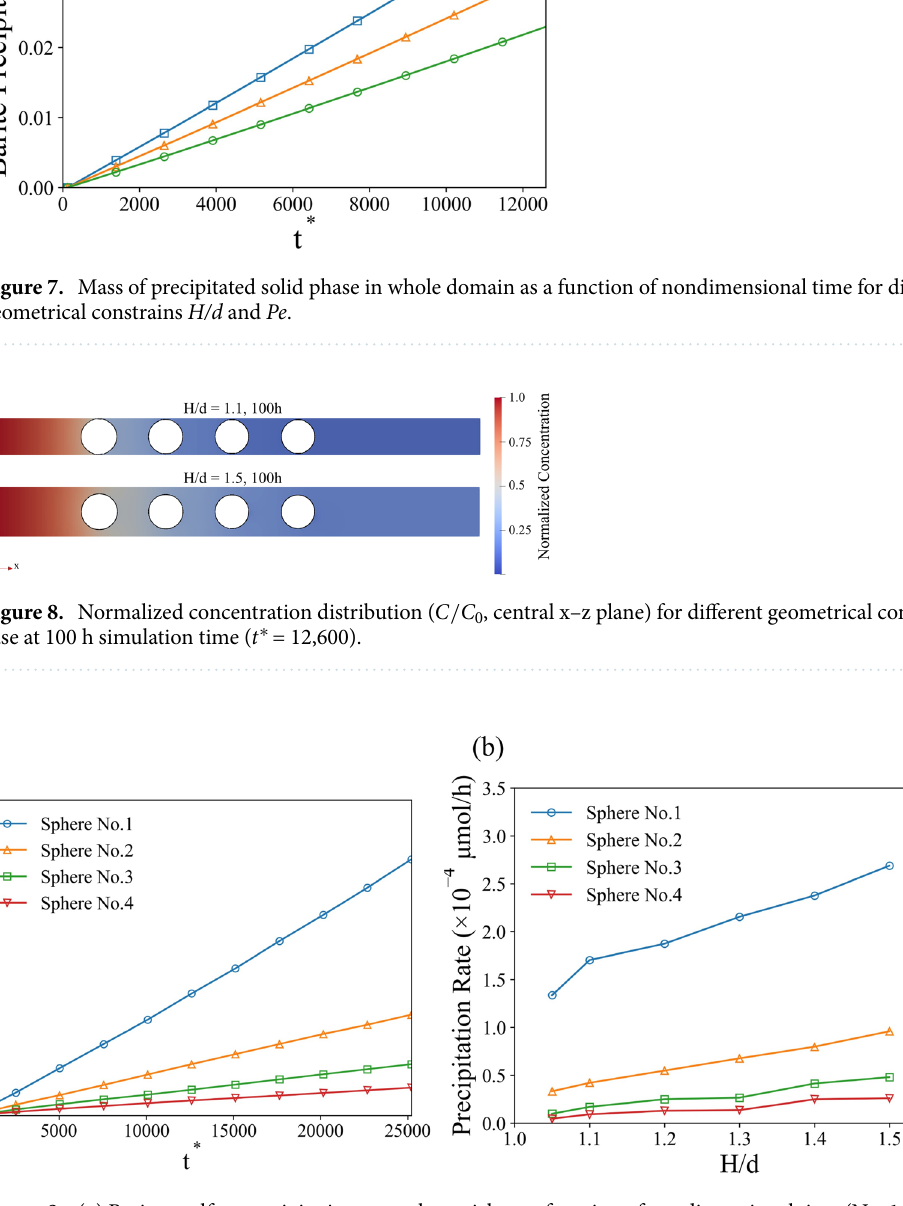
Figure 9. ( a ) Barium sulfate precipitation on each particle as a function of nondimensional time (No. 1–4 left to right). ( b ) Precipitation rate on each particle as a function of H/d